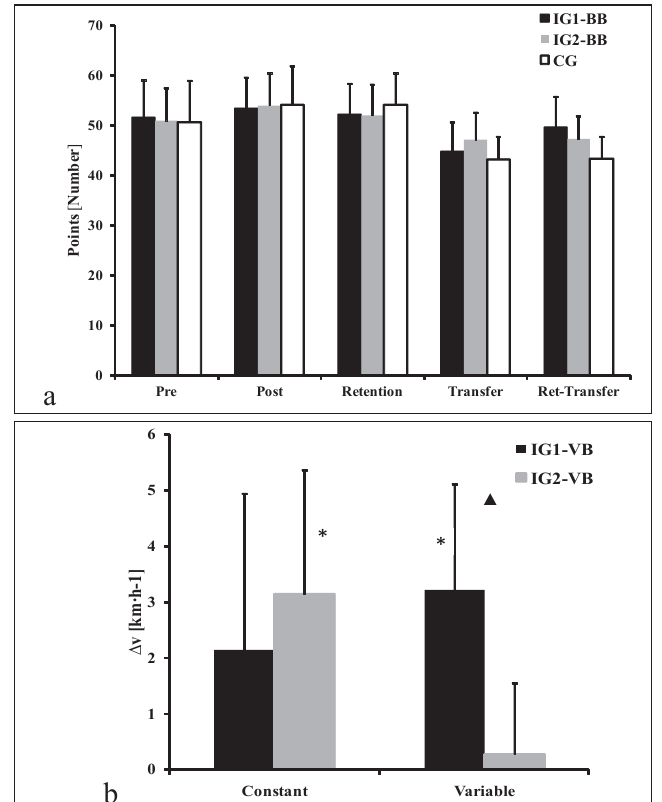
Figure 2 a. Mean values for the sum of points for all three groups at all test times